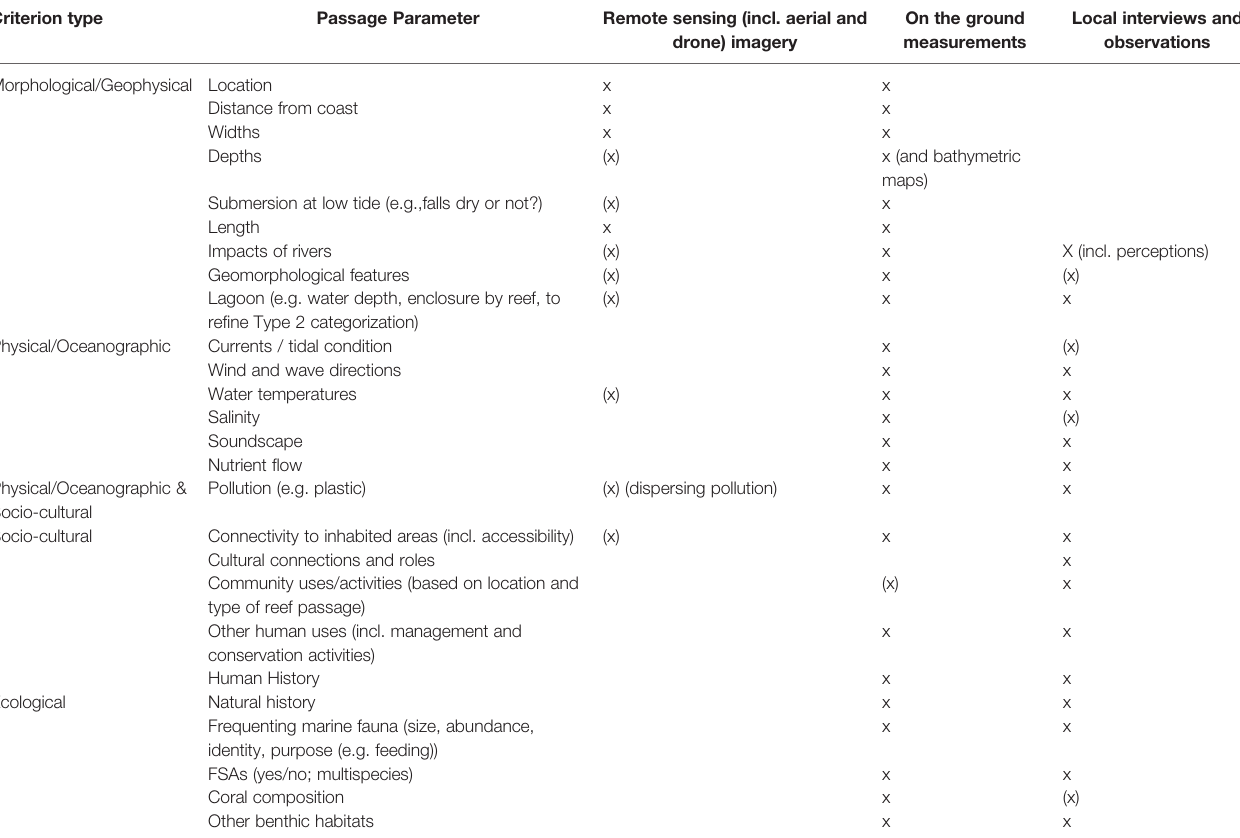
TABLE 2 | Candidate parameters and criteria for characterizing reef passages, to be included for a more comprehensive typology of reef passages, with the data on parameters generated remotely being the only ones available at this stage, and those generated by ‘ on the ground measurements ’ and ‘ local interviews ’ largely not being available yet [(x) means ‘ possibly, yet not easy to measure at spatial scale of interest in this study ’ ]. Criterion